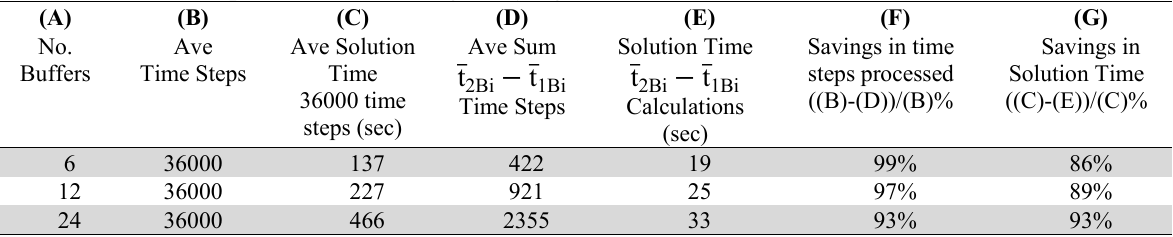
Calculation and computation time savings varying